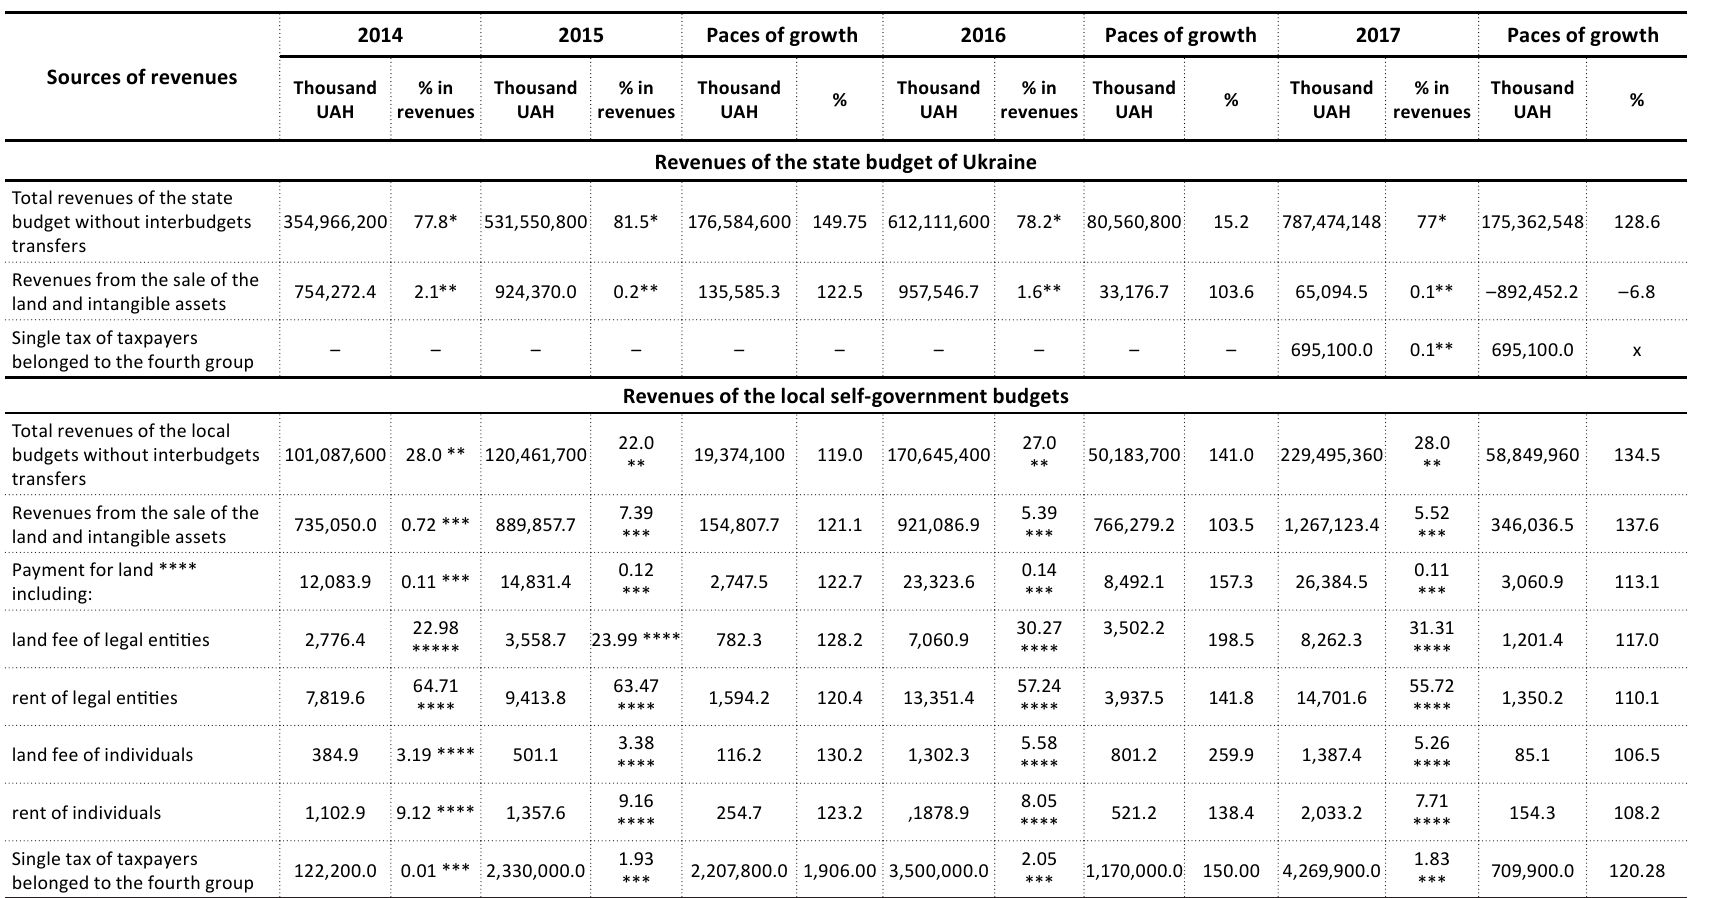
Table 1. Indicators of the execution of the state and local budgets of Ukraine in terms of revenues with regard to revenues from the sale of land, payment for land, and single tax of taxpayers belonged to the fourth group during 2014–2017 Source: The Ministry of Finances of Ukraine (2016), the State Treasury of Ukraine (2018), Accounting Chamber of Ukraine